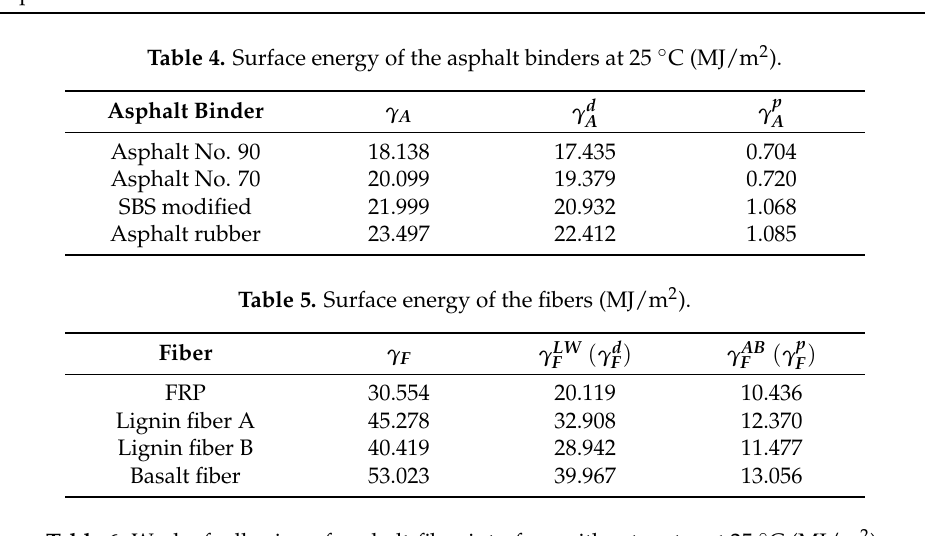
Table 6. Work of adhesion of asphalt-fiber interface without water at 25 ◦ C (MJ/m 2